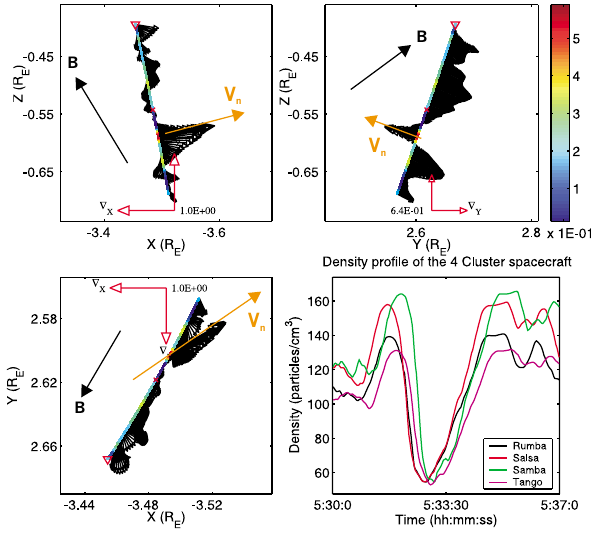
Fig. 8. Density gradient vector projections onto the XY, YZ, and XZ GSE planes for the density irregularity Z observed in the plas- masphere on 11 April 2002. B is the magnetic field and V n is the normal boundary velocity of the inner edge of Z. The density of the four spacecraft is plotted as a function of time in the lower right